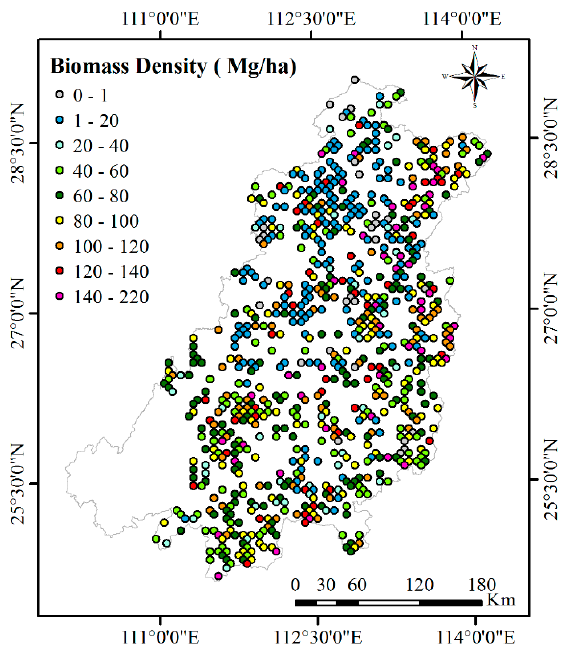
Figure 2. Spatial distribution of sampling plots and corresponding plot AGB values across the Xiangjiang River Basin. Xiangjiang River